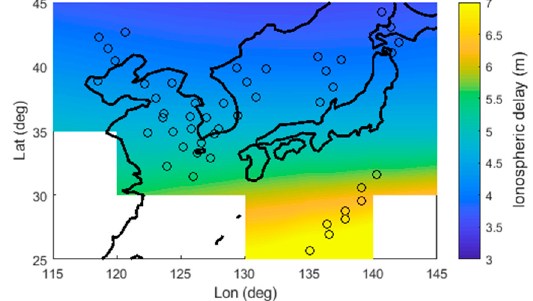
Figure 5. True ionospheric map.